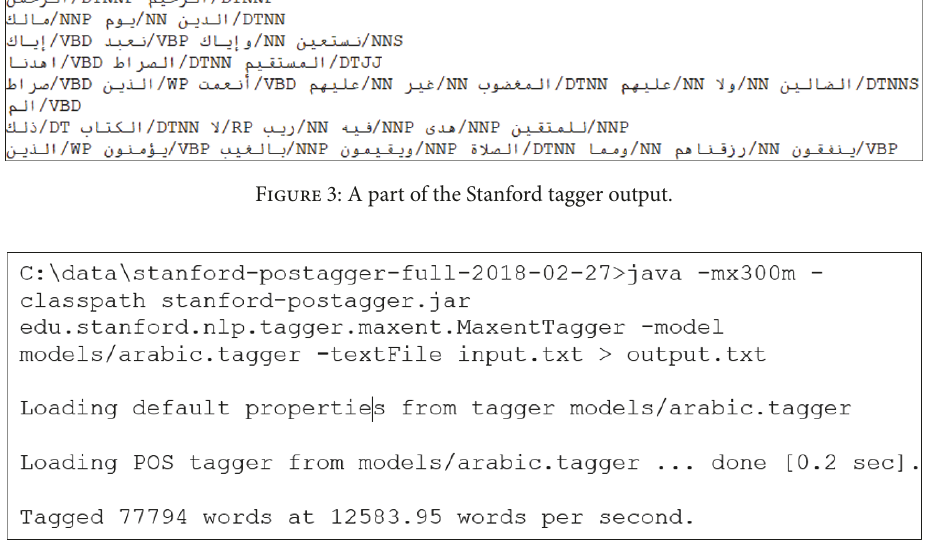
Figure 4: The running command of the Stanford